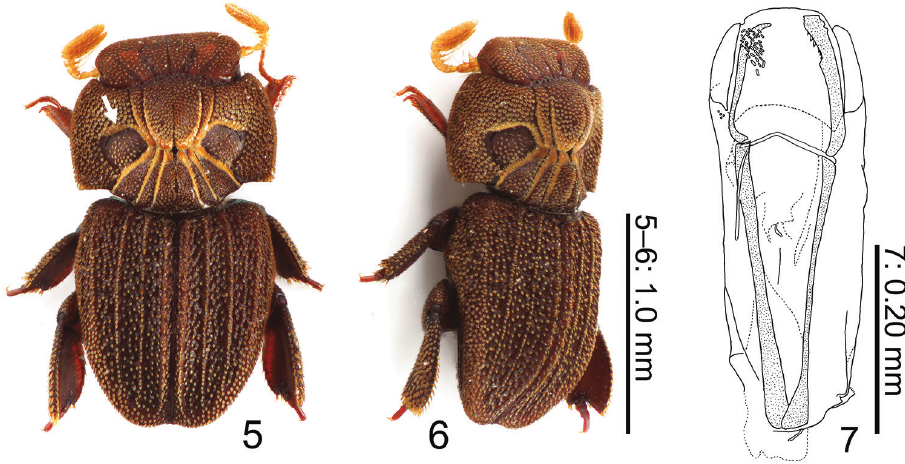
Figures 5–7. Habitus of Cheleion jendeki ( ♂ ) 5 dorsal view (anterior ridge of pronotal depression ar- rowed) 6 dorsolateral view 7 Aedeagus in dorsal view.